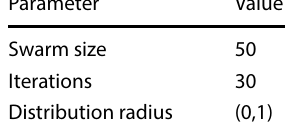
Table 6 Fruitfly